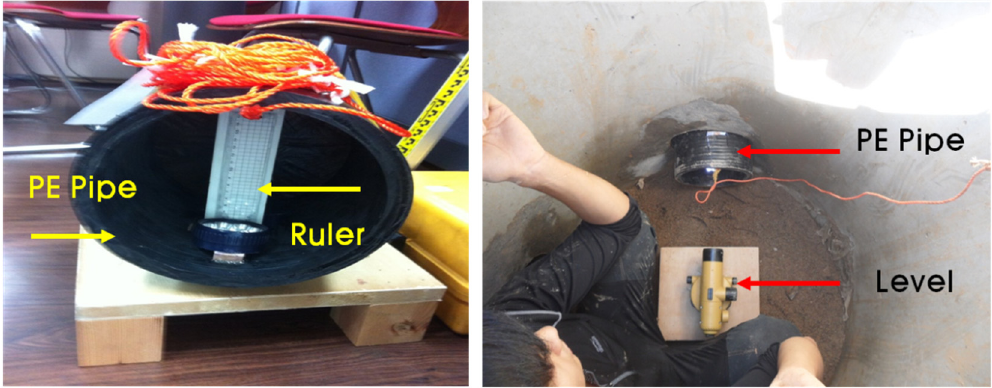
Figure 16. Measuring system of the second field